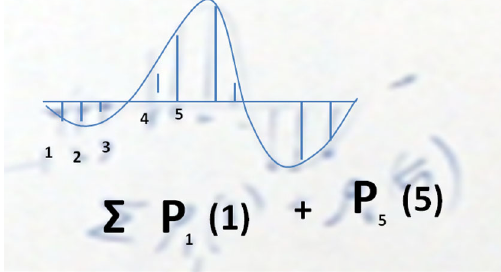
FIG. 6. Victoria created bars under the wave function to attempt summation for position. Typed numbers and symbols are added for legibility.